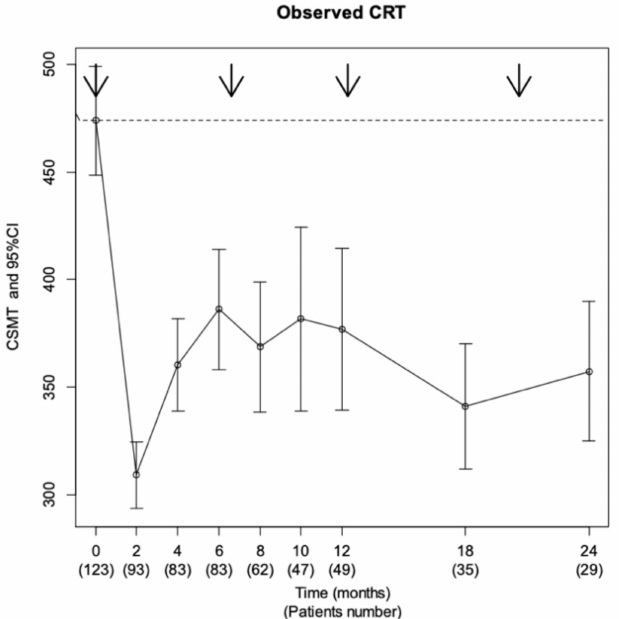
Figure 2. Anatomical efficacy. Evolution of mean central subfield macular thickness (CSMT) during the study period. Arrows represent the median dates of